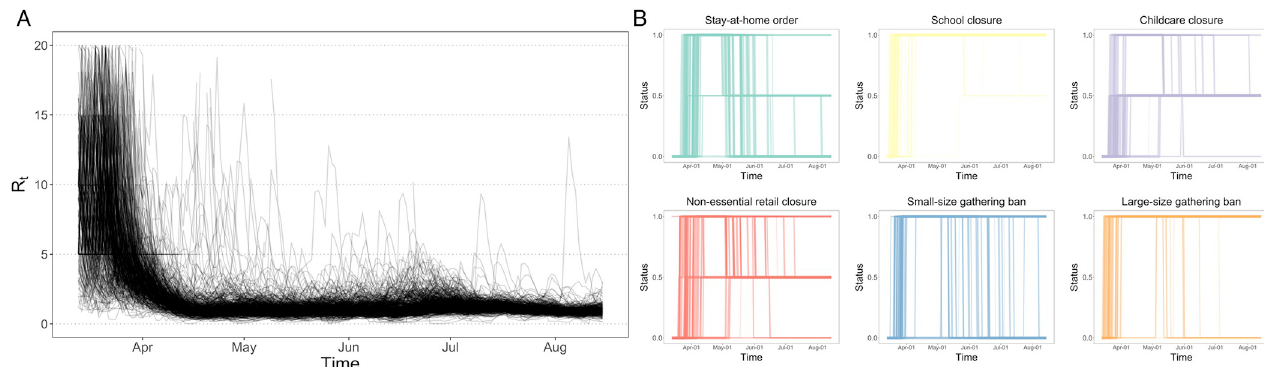
Fig 1. Epidemic course and interventions in the sample counties in the United States. (A) Dynamics of daily instantaneous reproduction numbers (R t ) in the sample counties. The reproduction numbers were high at the beginning of the pandemic, decreased in April and slightly upsurged in July. Nonetheless, there was much variation in the reproduction numbers across counties. (B) Dynamics of the six interventions. The interventions switched between none (0), partial restriction (0.5) and full restriction (1) during the study period. The widths of lines in the graphs are proportional to the number of counties in the corresponding status on the corresponding day. Since interventions were decided by individual states, the timing differed a lot across the sample counties, based on which the intervention effects could be estimated.